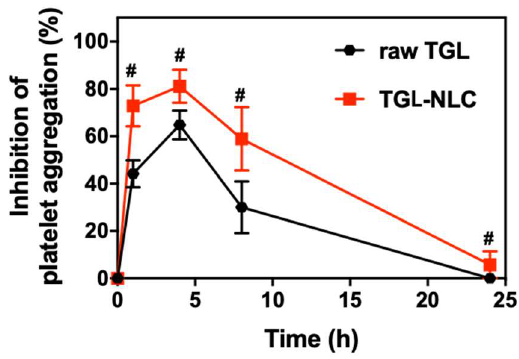
Figure 6. Ex vivo antiplatelet activities after single oral administration of raw TGL and TGL-NLC at a dose equivalent to 10 mg / kg of TGL. Data are expressed as the mean ± SEM (n = 6). # p < 0.05 vs. raw TGL at the same time-point. Table 6. Area under the inhibitory curves of platelet aggregation (AUIC) by administration of raw TGL and TGL-NLC in rats. Data are expressed as the mean ± SD (n = 6). # p < 0.05 vs. raw TGL.